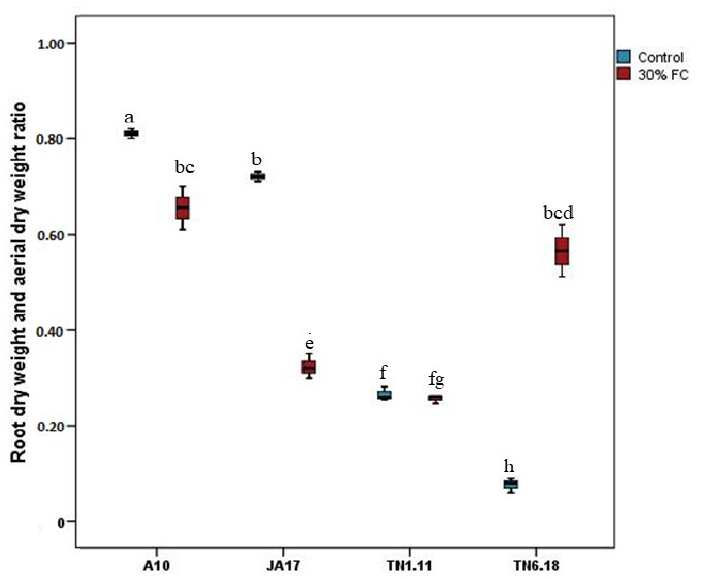
Figure 4. Means of root dry weight and aerial dry weight ratio for the four lines of M. truncatula under control treatment and water deficit stress. Means followed by the same or a common letter (s) are not significantly different among the studied lines for each trait according to Duncan’s test at 5%.